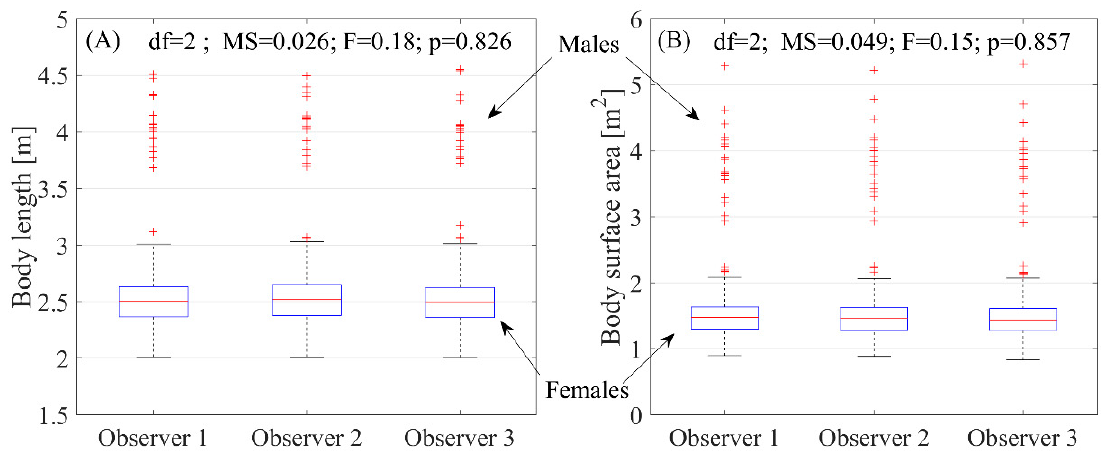
Figure 8. Observer precision in measurements of body length ( A ) and body surface area ( B ). The test was carried out for November 1.